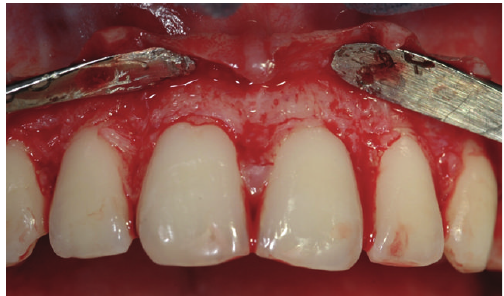
Figure 4: Submarginal incision 0.5 mm coronal to the CEJ level.